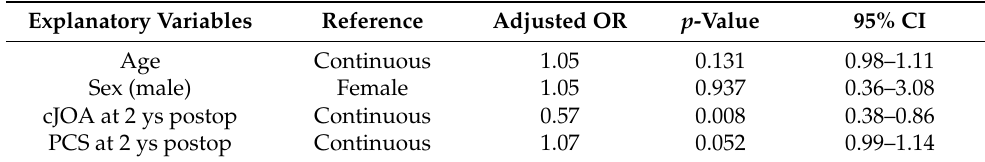
Table 4. Multivariate logistic regression analysis of factors associated with PCS deterioration 2 years postoperatively.